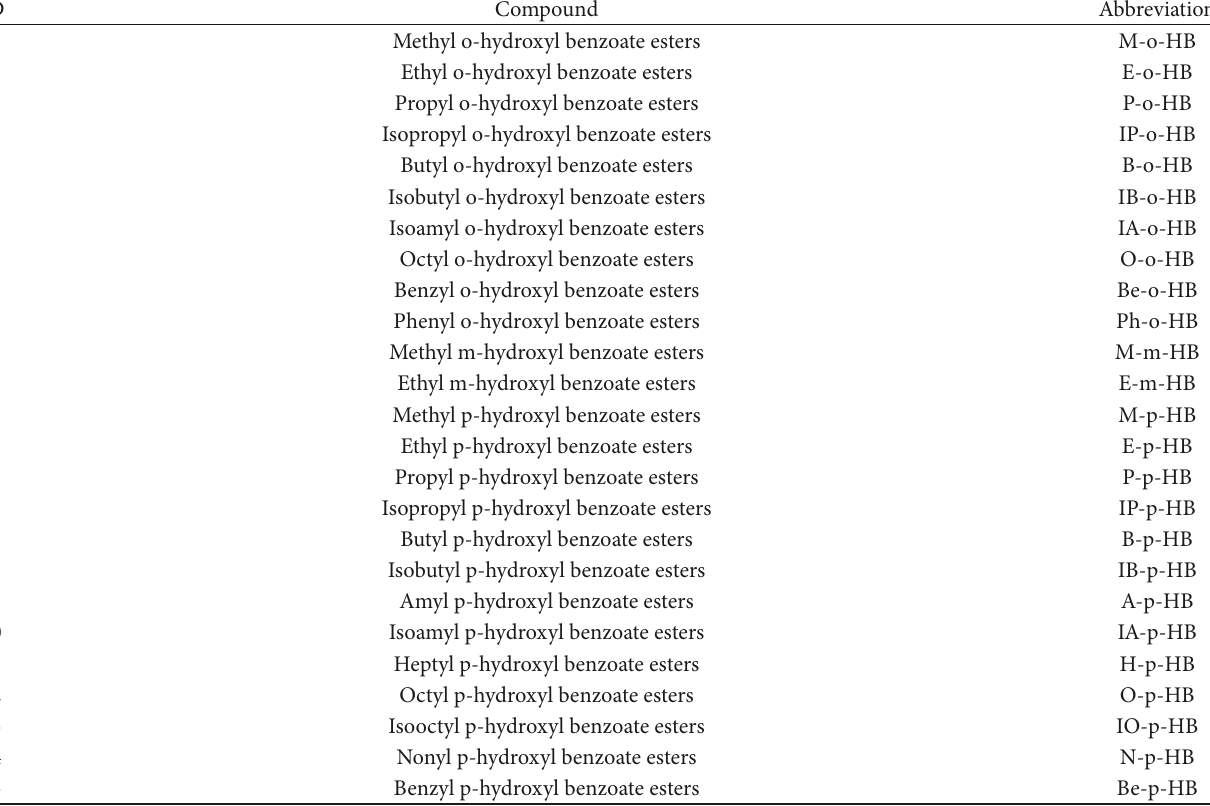
Table 1: The basic information of hydroxyl benzoate